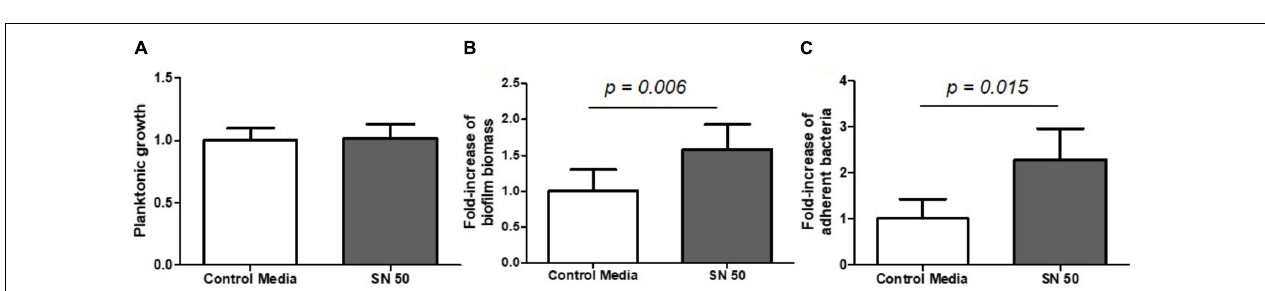
FIGURE 5 | Diluted supernatants of osteoblast culture influenced S. aureus biofilm formation. Planktonic growth normalized on control (A) biomass biofilm quantified by crystal violet staining (B) and fold-increase of live adhered cells (C) . Control media = 50% DMEM + 10% FCS and 50% of minimal medium; SN 50 = culture with 50% of osteoblast culture supernatants and 50% of minimal media. ( n =